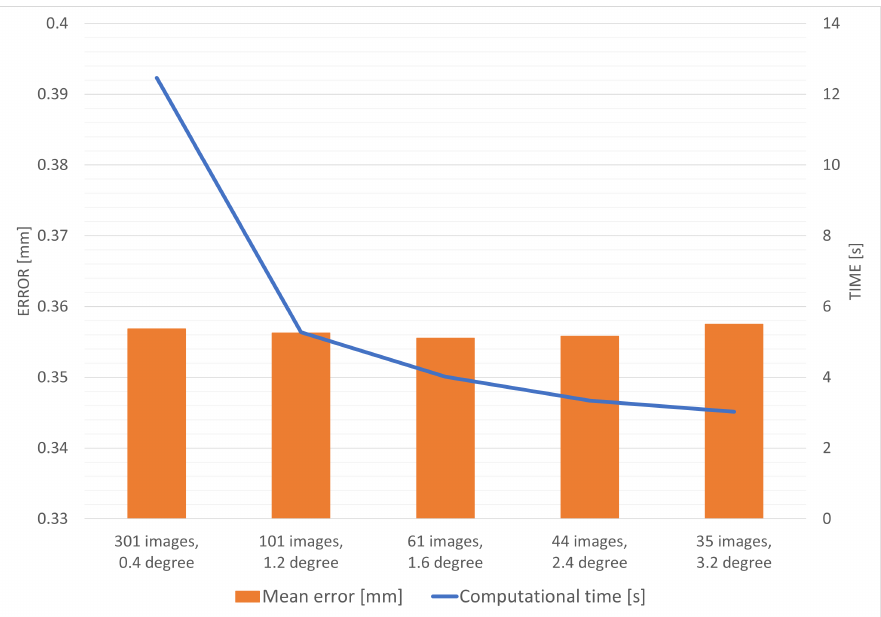
Figure 9. Graph of mean errors (orange bars) and computational time (blue plot) according to the different angular intervals applied to the calibration algorithm with the same range of the applied data; the angular interval ranges from 0.4 degrees to 3.2 degrees; the x-axis represents the angular interval of the image used in the calculation. The y-axis on the left gives the error, and that on the right gives the computational time.